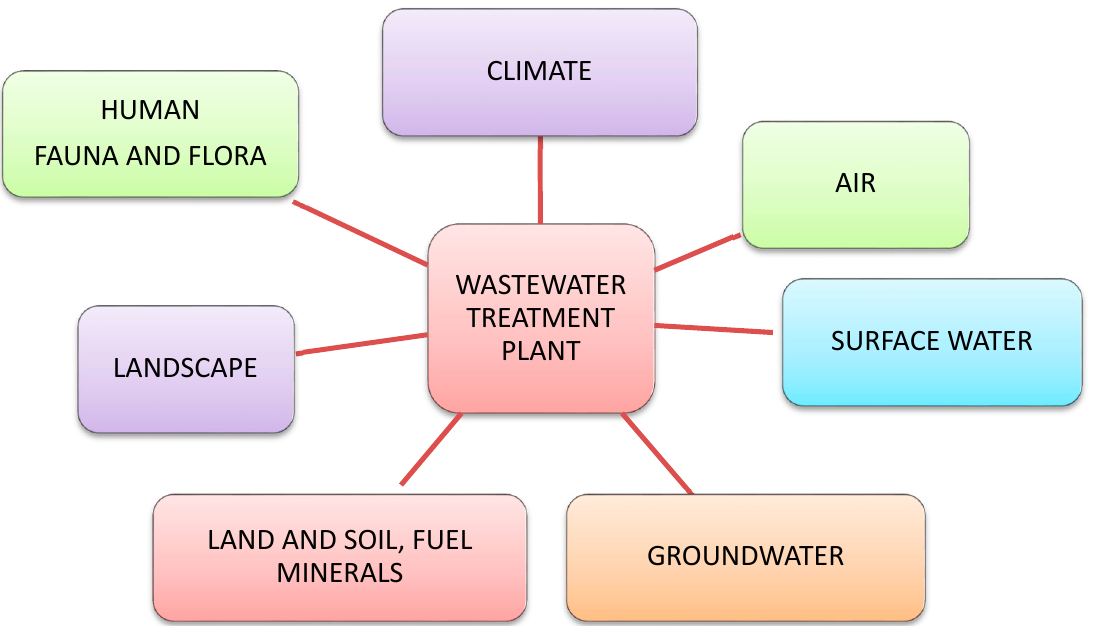
Figure 2. Environmental components influenced by the wastewater treatment plant during operation and/or failure.